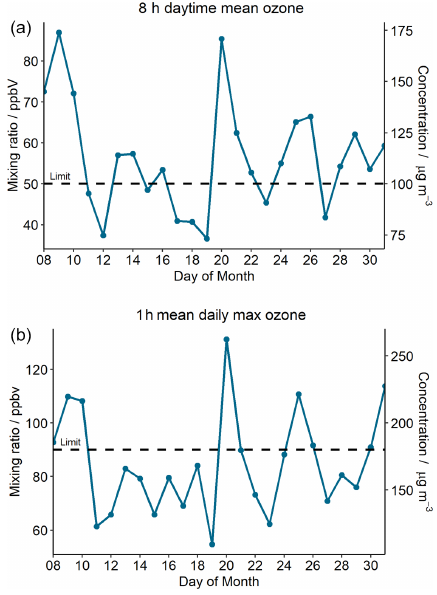
Figure 4. The 8h mean O 3 concentration between 09:00 and 17:00IST (a) and hourly averaged maximum daily O 3 concentra- tion (b) during October 2018. The dashed black line shows the pre- scribed national standards for O 3